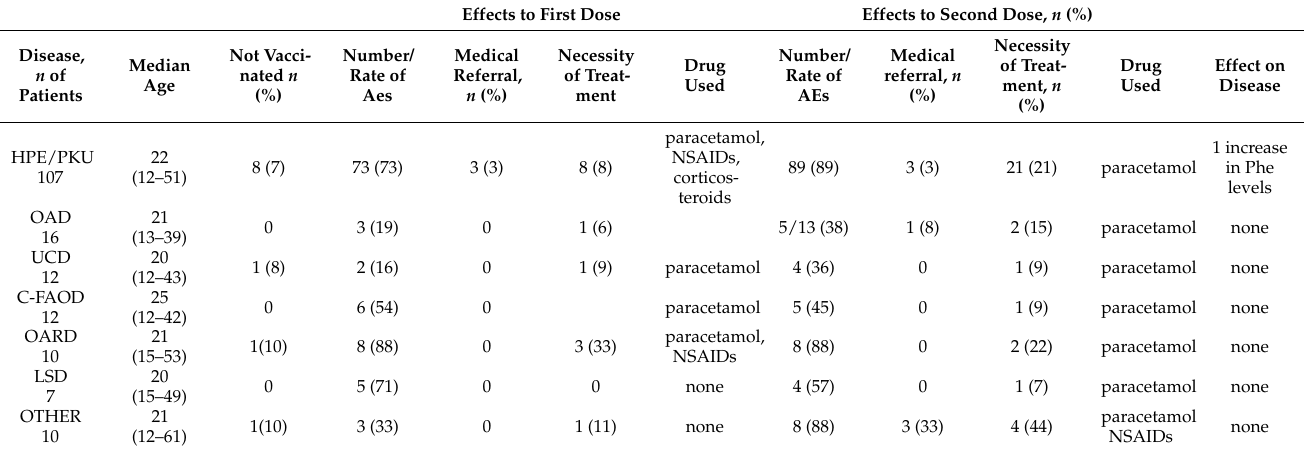
Table 3. Effects of the first and second dose of the COVID-19 vaccine based on the type of conditions. Effects to First Dose Effects to Second Dose, n (%)